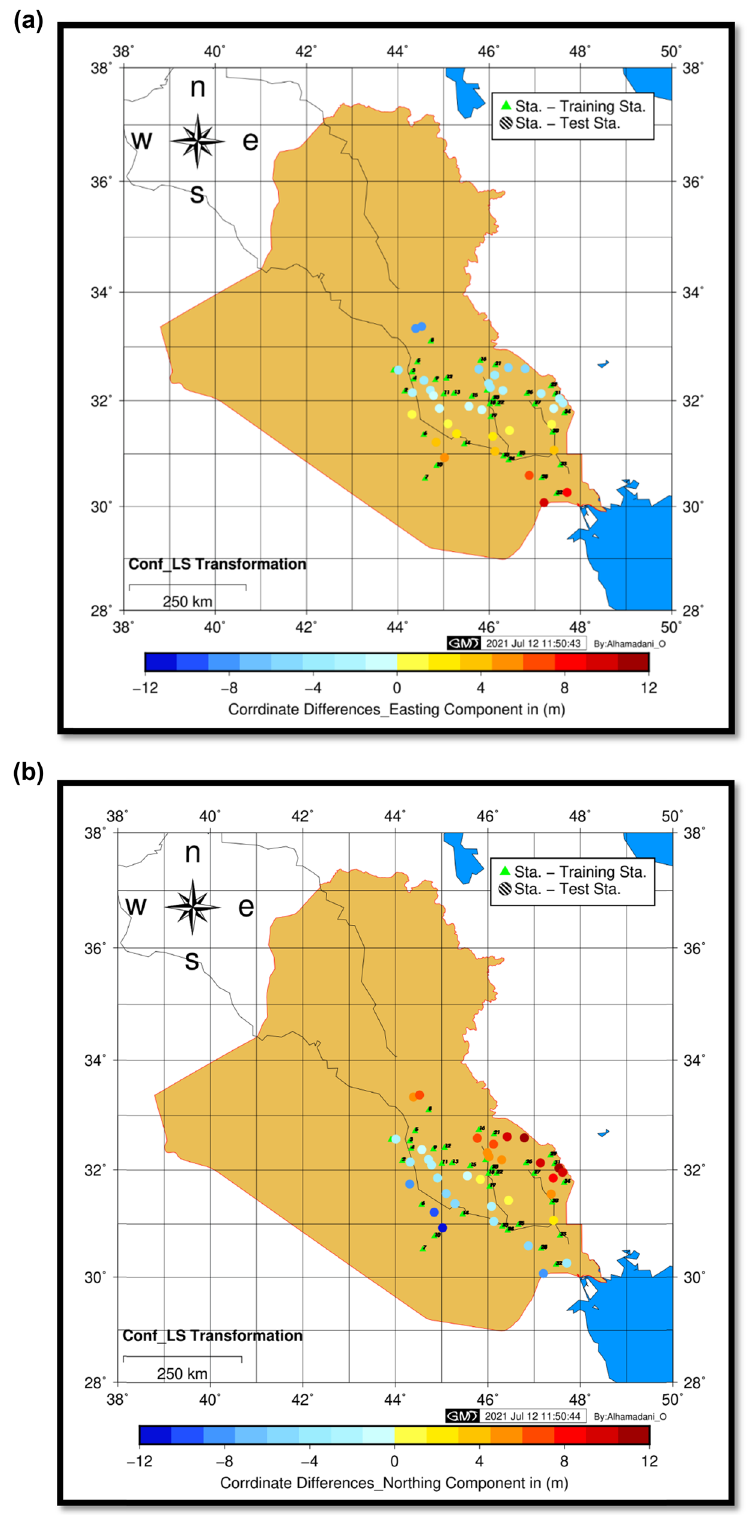
Figure 10: ( a ) Color scale accuracy for the 2D conformal least square method for easting. ( b ) Color scale accuracy for the 2D conformal least square method for